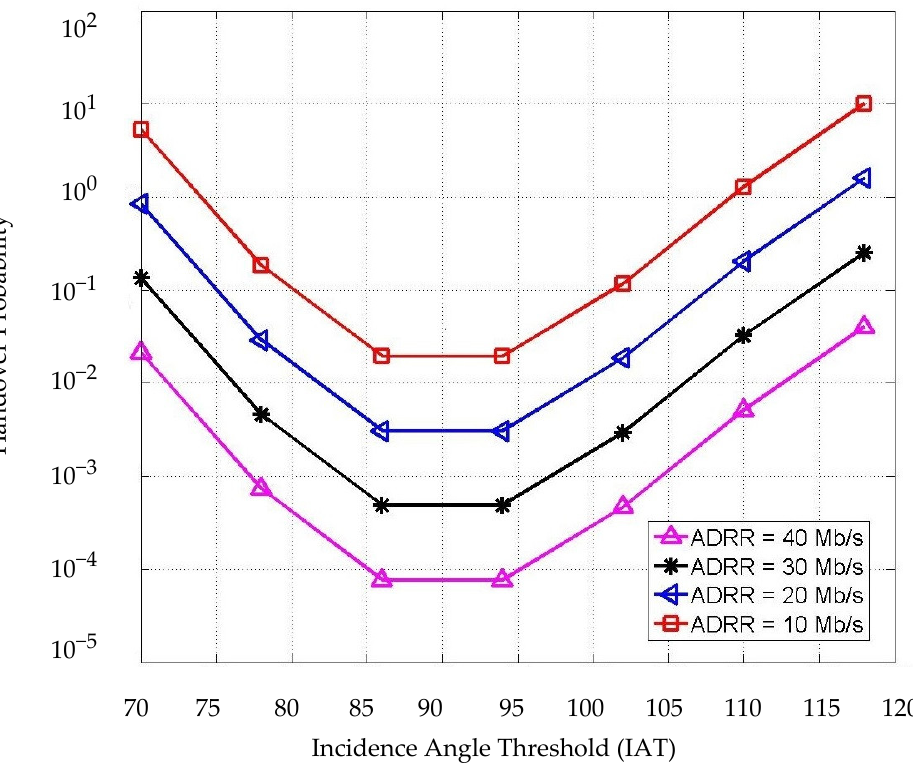
Figure 9. Handover Probability with the corresponding to the IAT, the expectation of the handover overhead is 25 ms. overhead is 25 ms.